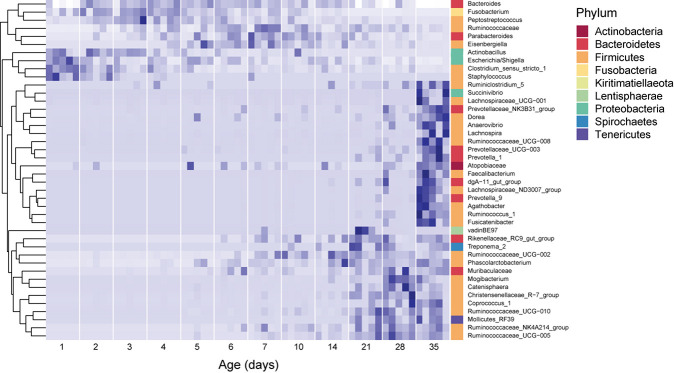
Core dynamic genera in the fecal microbiomes of pigs of different ages. The responses of 42 genera which exhibited consistent, significant changes over the period studied are displayed. For each taxon, the intensity of the blue color represents the proportion of total observations of that taxon across the whole dataset (Shade et al., 2013). These genera represent 54.2 ± 12.7% of the community, on average. Relative abundances were standardized by time, per genus, and genera were clustered according to the resulting temporal response patterns using Ward’s distance. Intensity of the blue color indicates the relative abundance of each taxon at each age group. Replicate samples are shown as columns within each age group. The lowest available classification of each genus is listed on the right, and phylum membership is indicated by the color bar on the right.